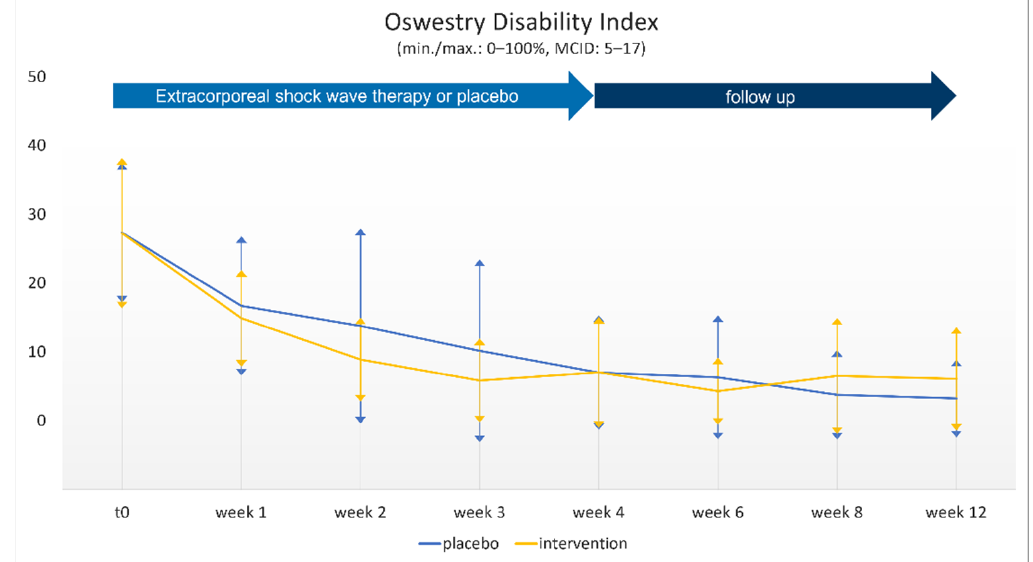
Figure 3. Physical function according to the Oswestry disability index (ODI; mean (SD)) for the two groups (intervention vs. placebo) at the eight different time points.